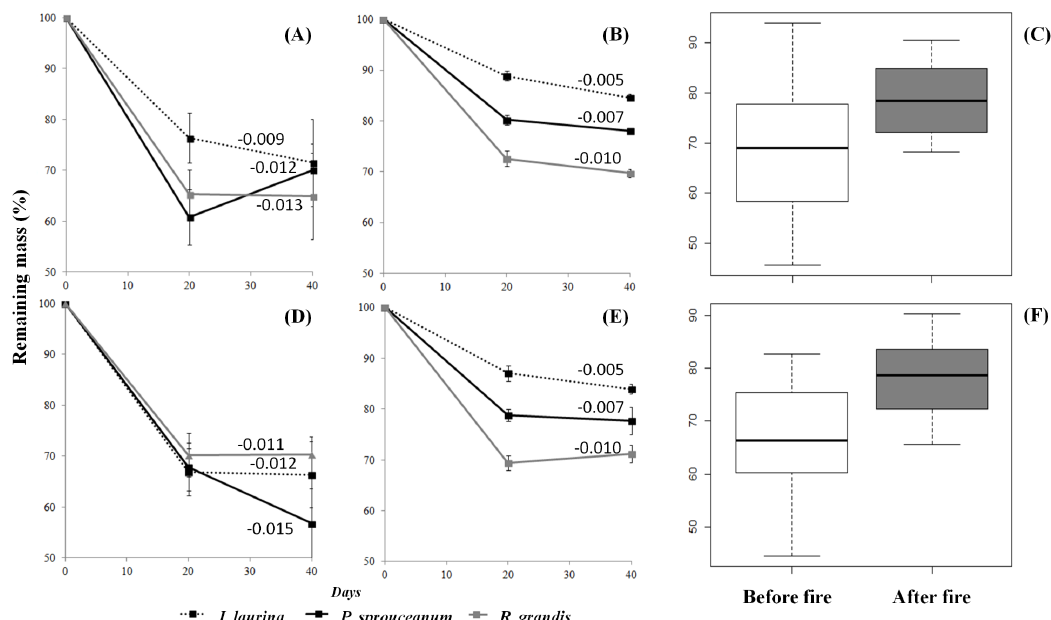
Figure 2. Remaining mass (%) in fine (A, B and C) and coarse (D, E and F) mesh litter bag before (A, D and white in C and F) and after (B, E and gray in C and F) fire for leaf litter of I. laurina, P. spruceanum and R. grandis in a stream in a ecotone between Savannah and Tropical Rain Forrest stream. The negative numbers are k values.